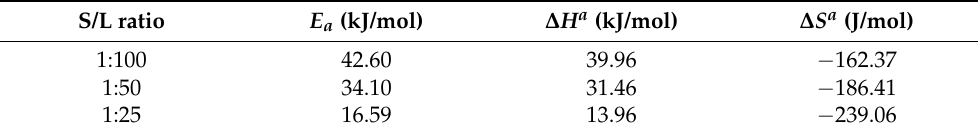
Table 2. Apparent activation energy, activation enthalpy and activation entropy calculation results.